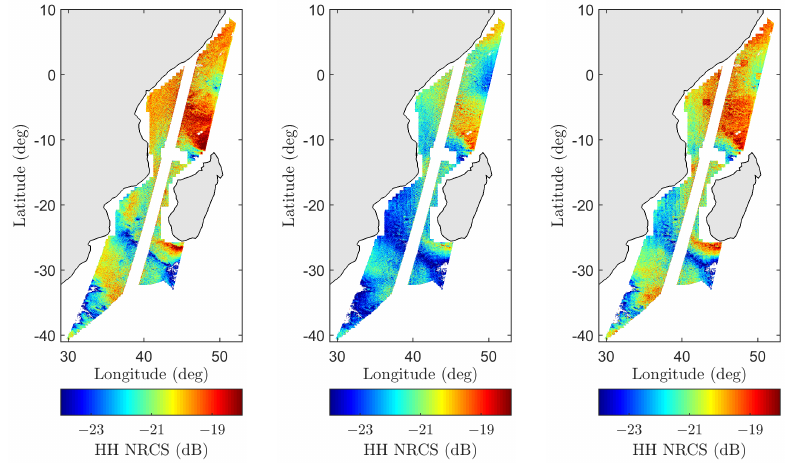
Figure 17. SMAP 1 km high-resolution measured and modeled backscatter NRCS maps for passes 02260_D shown in Figure 16. From ( left ) to ( right ): SMAP, wind-only model, and wind and swell model.